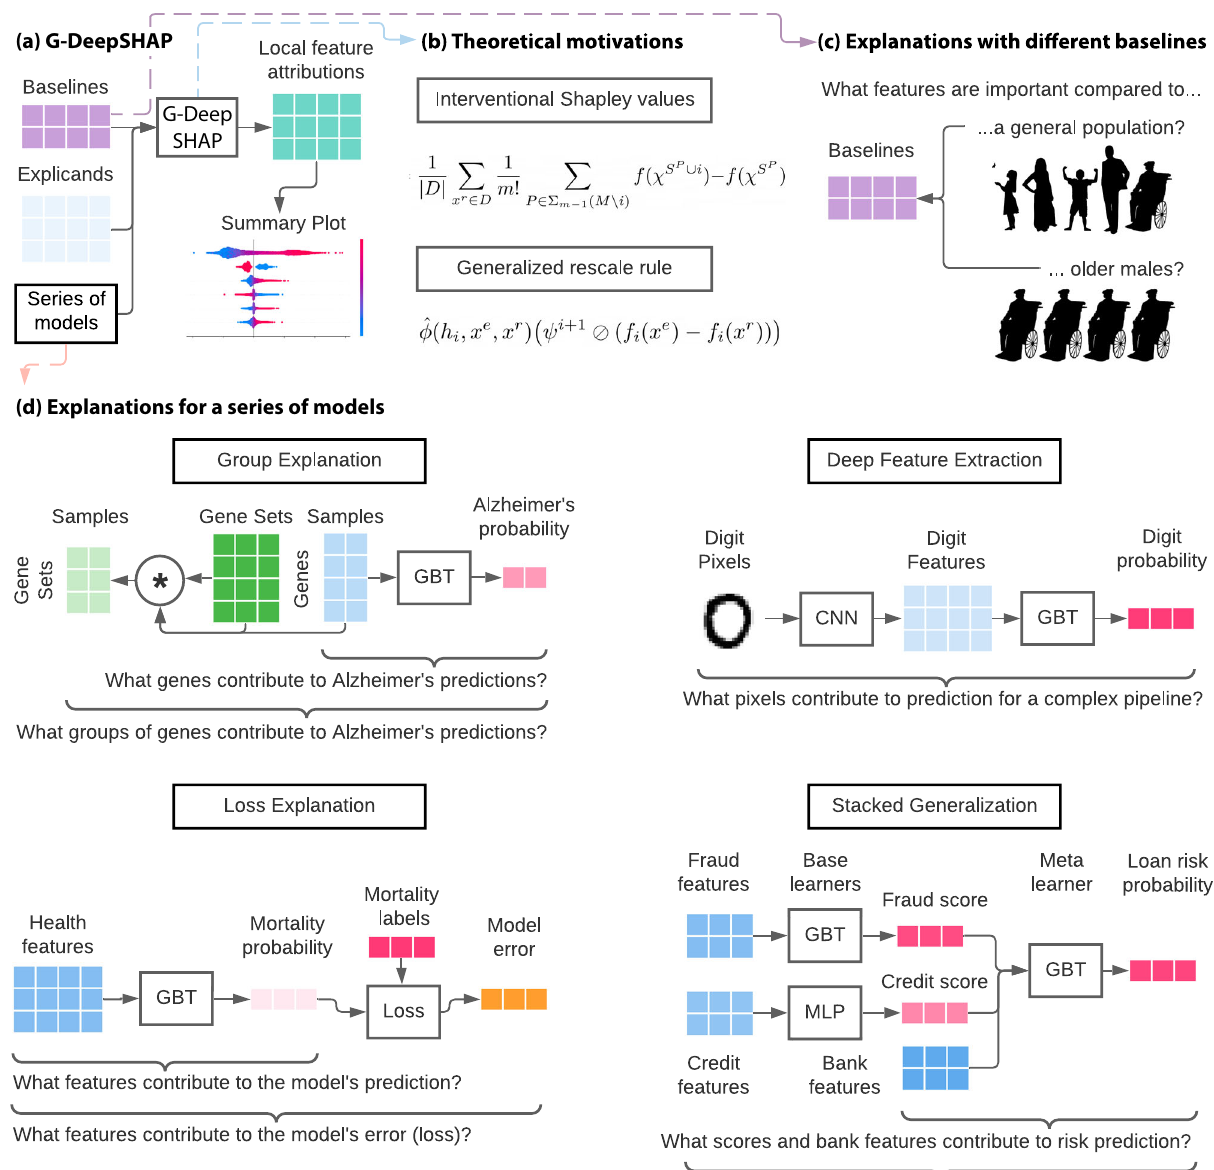
Fig. 1 G-DeepSHAP estimates Shapley value feature attributions to explain a series of models using a baseline distribution. a Local feature attributions with G-DeepSHAP require explicands (samples being explained), a baseline distribution (samples being compared to), and a model that is comprised of a series of models. They can be visualized to understand model behavior (Supplementary Methods Section 1.3). b Theoretical motivation behind G-DeepSHAP (Methods sections The Shapley value and A generalized rescale rule to explain a series of models). c The baseline distribution is an important, but often overlooked, a parameter that changes the scienti fi c question implicit in the local feature attributions we obtain. d Explaining a series of models enables us to explain groups of features, model loss, and complex pipelines of models (deep feature extraction and stacked generalization). Experimental setups are described in Supplementary Methods Section the correct way to obtain the interventional Shapley value local DeepLIFT 17 explains deep models by propagating feature feature attributions (denoted as ϕ ð f ; x e Þ 2 R m ) based on an attributions at each layer of the deep model. Here, we extend explicand ( x e 2 R m ), or sample being explained, is to average DeepLIFT by generalizing DeepLIFT ’ s rescale rule to accom- over single baseline feature attributions (denoted as modate more than neural network layers while guaranteeing ϕ ð f ; x e ; x b Þ 2 R m ) where baselines are x b 2 R m and D is the set layer-wise ef fi ciency (details in Methods section A generalized of all baselines (details in Methods section Interventional Shapley rescale rule to explain a series of models). For a series values baseline distribution): of models which can be represented as a composition of : R m i ! R o i , functions ( f k ( x ) = ( h k ∘ ⋯ ∘ h 1 )( x ), where h i m i = o i − 1 ∀ i ∈ 2, ⋯ k , m 1 = m , and o k = 1) with intermediary ð 1 Þ models ( f i ( x ) = ( h i ∘ ⋯ ∘ h 1 )( x )). In words, m i are the input dimensions and o i are the output dimensions for each layer i .